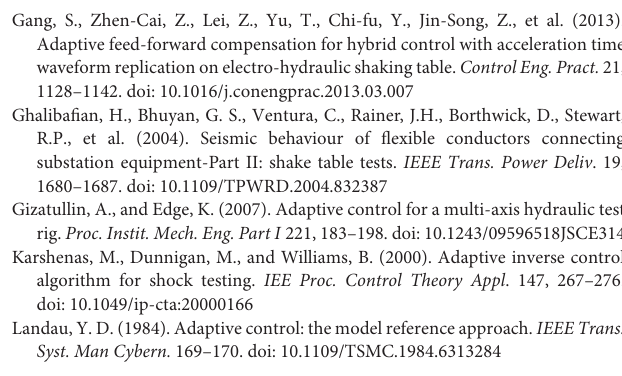
(4) Accurate information about the controlled plant is